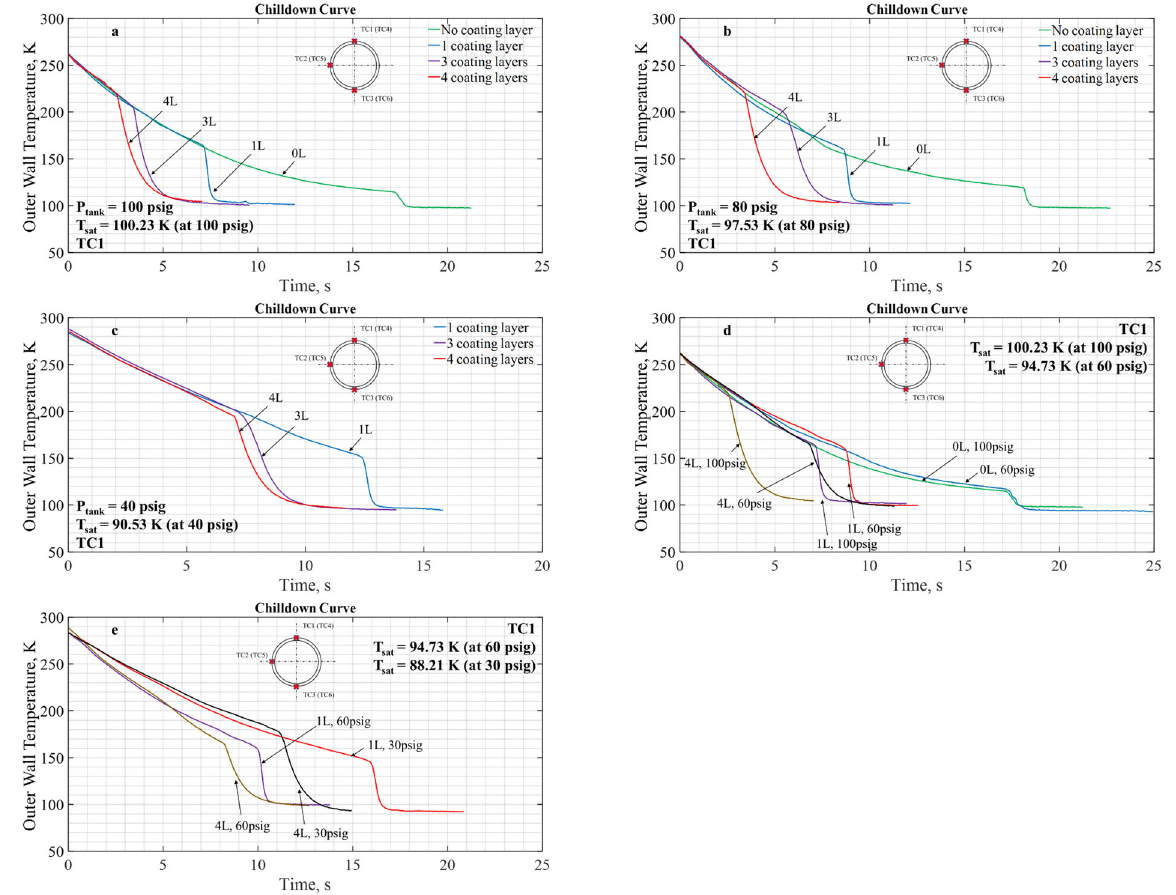
Fig. 5 The chilldown curves for various coating layer thicknesses and different source pressures. Chilldown results for inlet pressures of 100, 80, and 40 psig are shown in a , b , and c , respectively. For a and b , each presents four chilldown curves that correspond to three coating thicknesses plus one bare surface without any coating, while c only presents three curves as mentioned in the “ Methods ” section that the bare surface case was not performed for the 40 psig case due to lack of liquid nitrogen supply. Panels d and e plot the results for TC1 at the upstream station where chilldown curves are shown for 0, 1, and 4 tubes under 100, 60, and 30 psig. a 100 psig inlet pressure. b 80 psig inlet pressure. c 40 psig inlet pressure. d 100 psig and 60 psig inlet pressures. e 60 psig and 30 psig inlet